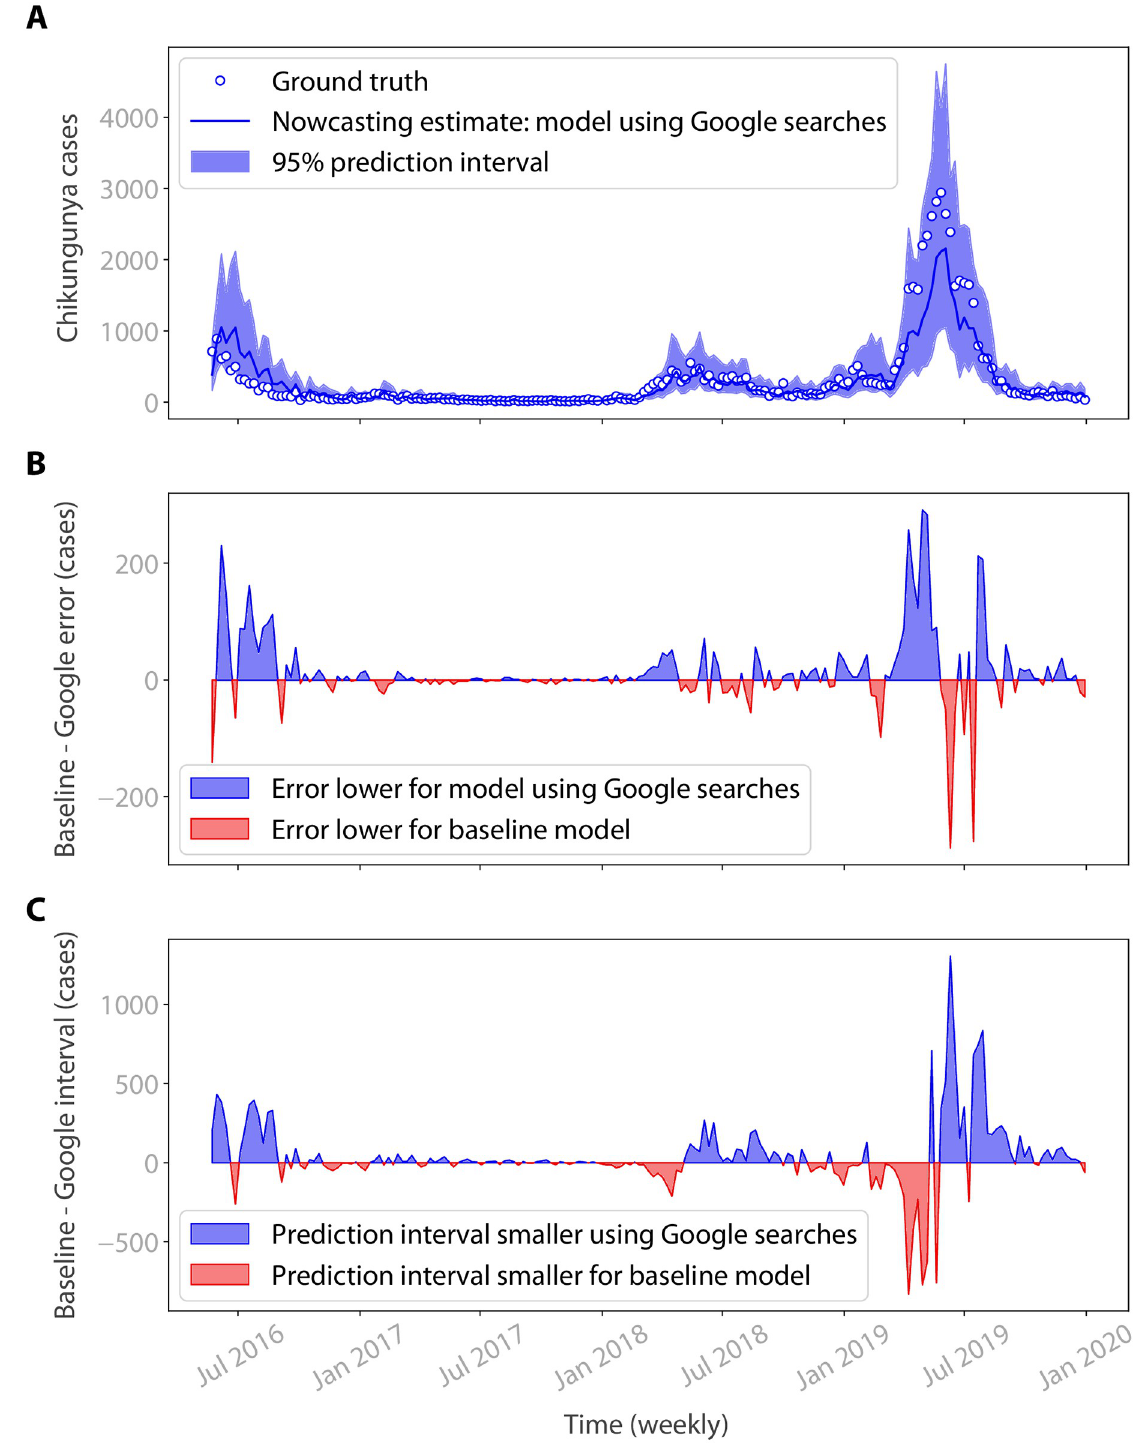
Fig 3. Performance of the nowcasting model using Google searches. A) Nowcast results over time for the model using data on Google searches for chikungunya. The model’s estimates are relatively accurate across the sample. Moreover, the ground truth rarely falls outside the 95% prediction intervals. B) A comparison of relative nowcast errors, in case numbers, between the baseline nowcasting model and nowcasting model using Google searches. Blue indicates that error is lower for the model using Google searches, and red indicates that error is lower for the baseline model. Overall the errors produced by the model using Google searches are lower, although there is some volatility around epidemic periods. C) A comparison of relative prediction interval width, in case numbers, between the baseline model and